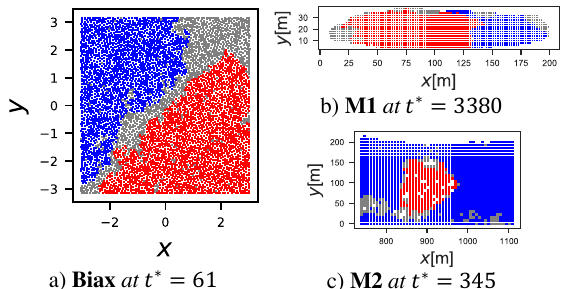
Fig. 4. The physical-kinematic clusters 𝐶( 𝑡 ∗ ) in the physical space. The fastest-moving cluster (red) is the “active” or high landslide risk region in M1 and M2 . Gray grains or pixels do not belong to the kinematic